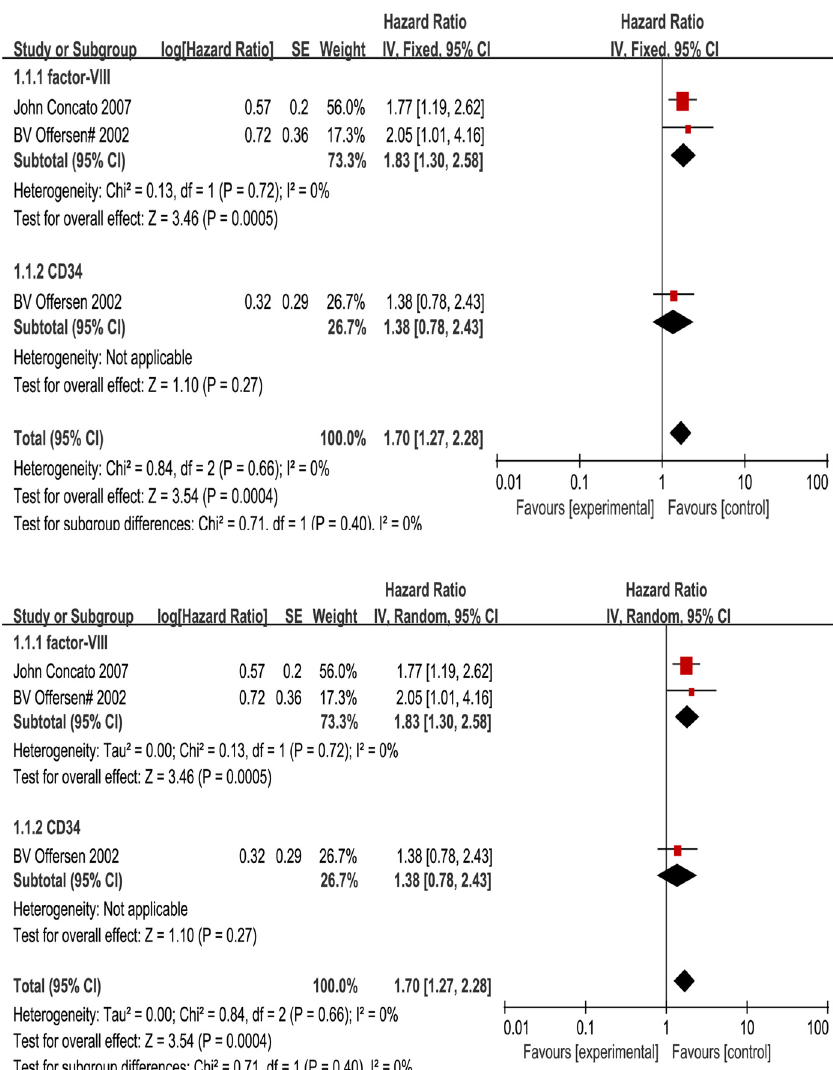
Figure 3: Meta - analysis ( forest plot ) of 2 eligible studies with 3 data sets assessing ( microvessel density ) MVD in OS of prostate cancer patients. The pooled HR ( its 95% CI ) for OS is 1.70 ( 1.27, 2.28 ) . Subgroup analysis considering endothelial markers for factor - VIII, HR = 1.83 ( 1.30, 2.58 ) ; for CD34, HR = 1.38 ( 0.78, 2.43 ) . Each study is shown by the fi rst author/year and the HR with 95%